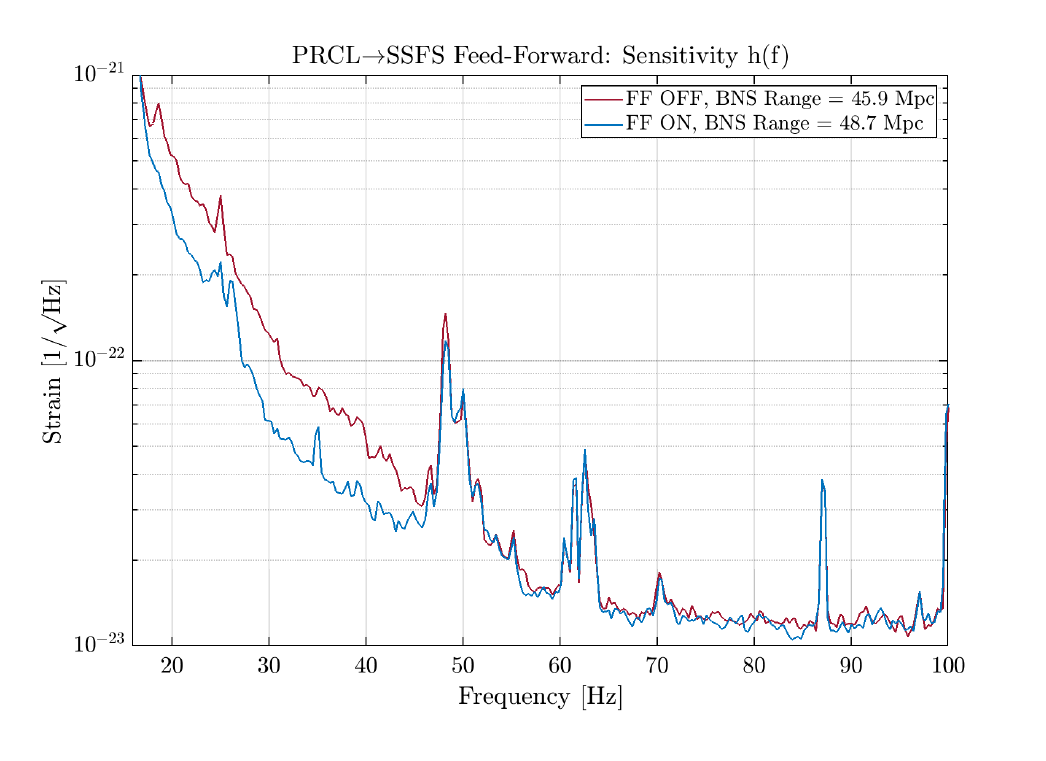
Figure 11. PRCL to SSFS Feed-Forward: improvement to the sensitivity